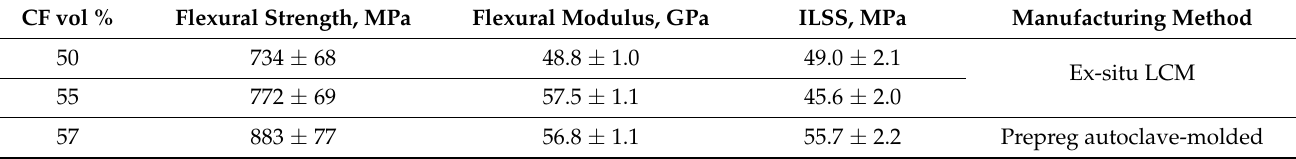
Table 4. Typical mechanical properties of CF composites produced by ex-situ LCM and autoclave in comparison. CF vol % Flexural Strength, MPa Flexural Modulus,